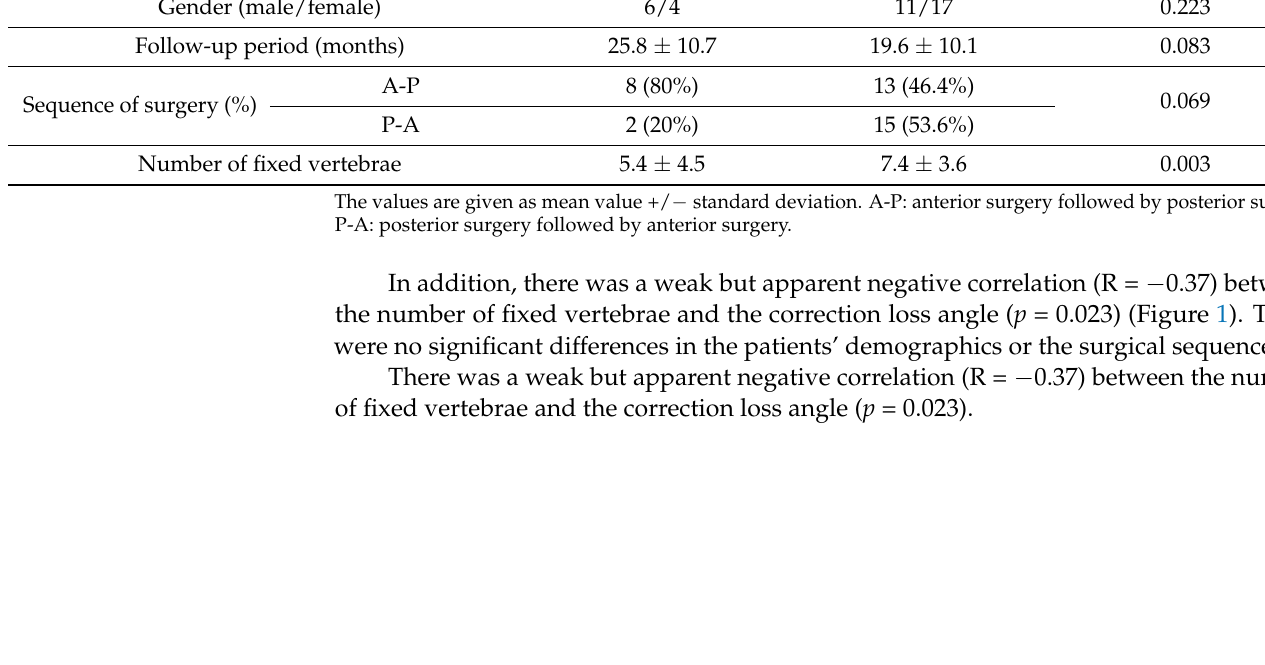
Table 2. Comparison between patients with cage subsidence (+) and without cage subsidence ( − ). Variables Cage Subsidence (+) Cage Subsidence ( − ) p -Value Number of